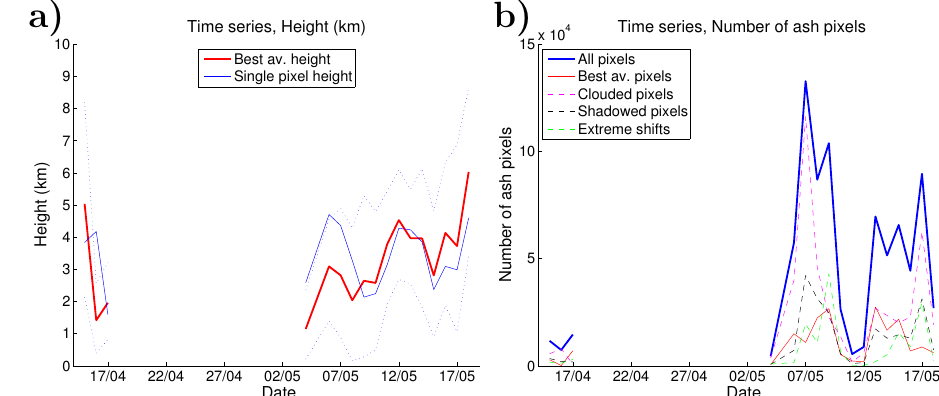
Figure 15. Time series of daily average heights and number of ash pixels. The blue lines give the average values using all pixels (SPH), and the red lines give average values using the filtered pixels only (BAV). The dotted blue lines on the left show the error bars (standard deviation). On the right we also show the number of pixels flagged as clouded or shadowed and also the number of pixels with an extreme (maximum or zero) along-track pixel shift. Table 4. Daily average heights (standard deviations) for the Eyjafjallajökull eruption and mask fractions for daytime orbits. N is the number of pixels with a valid height estimate, and bav frac. gives the fraction of filtered (best-average-height) pixels. The other fractions give the portion of pixels flagged by the cloud and shadow masks. In addition to the best average heights (BAV) and single-pixel heights (SPH) calculated with the largest correlation window size (CWS 11 × 11), we show the single-pixel height calculated simultaneously with two smaller correlation window sizes; the medium window height (MwH, 9 × 9) and the small window height (SwH, 7 × 7). Heights are given in kilometers a.s.l.